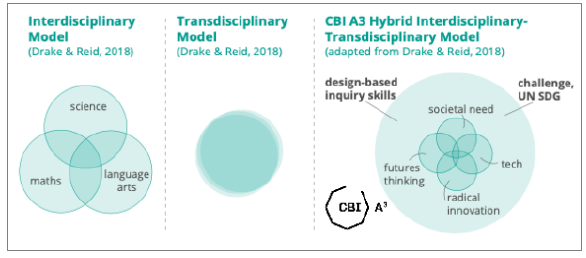
Fig. 1. Models of integrated curriculum